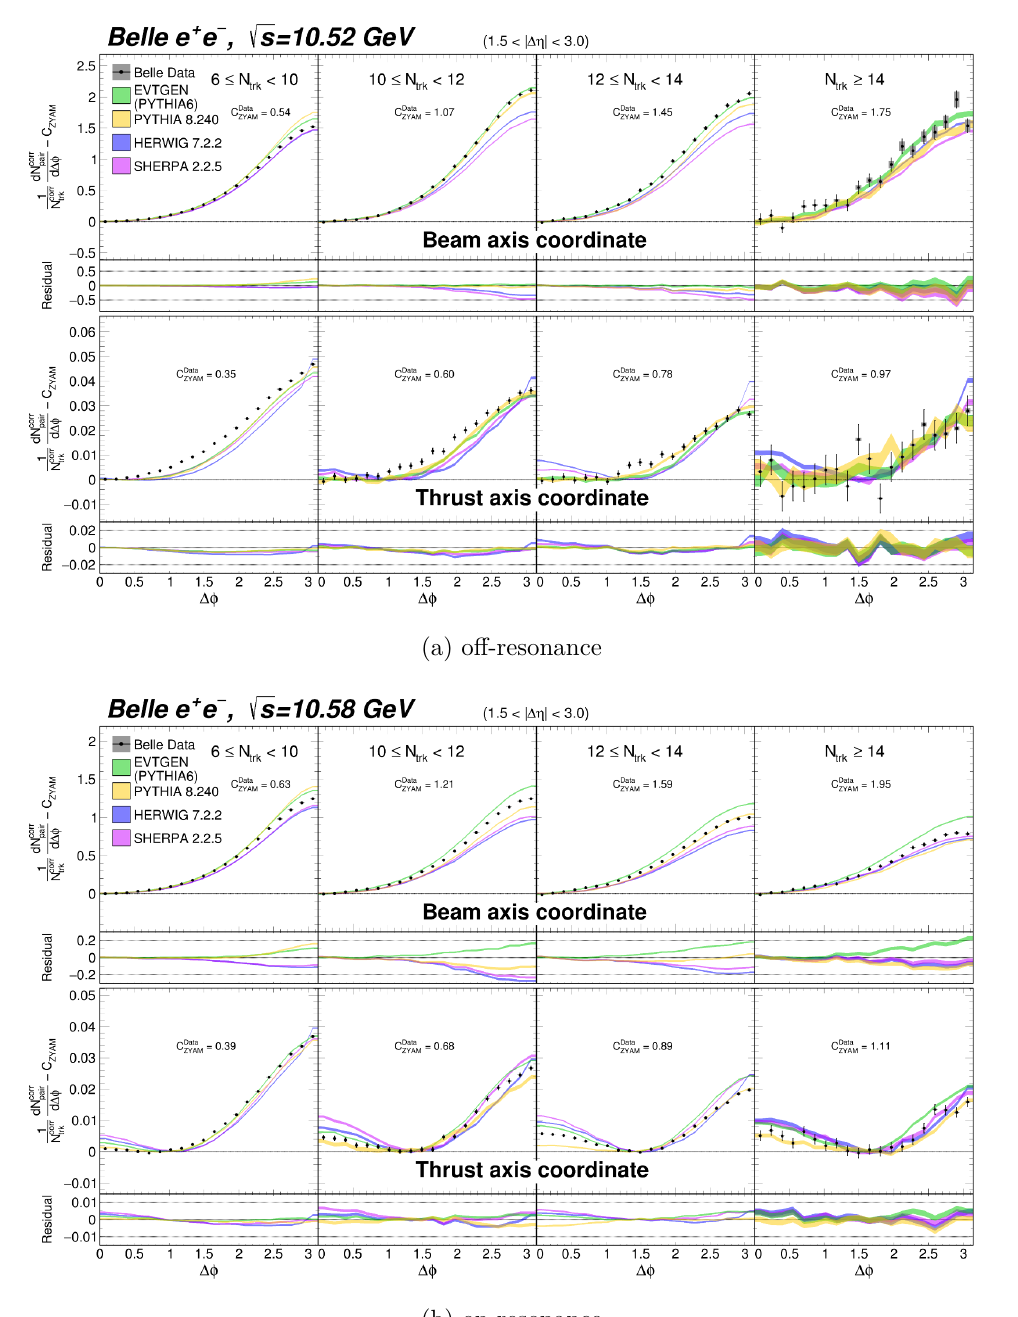
Figure 10. Comparison of the ZYAM-subtracted Y (∆ φ ) in the range 1 . 5 ≤ | ∆ η | < 3 . 0 for beam (top) and thrust (bottom) axis analyses as a function of the charged-particle multiplicity. The colored bands show simulation predictions from pythia 6 (green), pythia8 (yellow), herwig (blue) and sherpa (violet). Reconstruction effects on data (data points) are corrected, with error bars representing associated statistical uncertainties, and the gray boxes the systematic uncertainties. For visual purposes, the minimal statistical uncertainties of the MC correlation colored bands are set to be 0 . 4% of the plotting ranges, and residual panels have minimum thresholds of 3% of the plotting